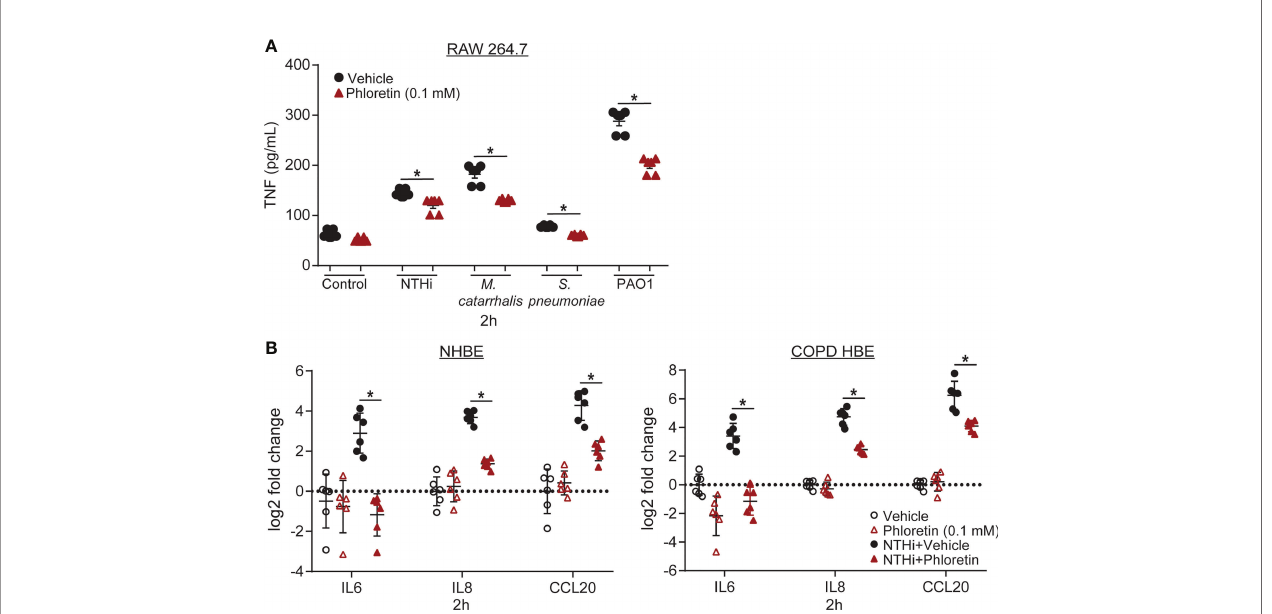
FIGURE 2 | Phloretin exhibits anti-in fl ammatory activity in COPD pathogen-induced RAW 264.7 cells and nontypeable Haemophilus in fl uenzae (NTHi)-induced human bronchial epithelial (HBE) cells. (A) COPD pathogens signi fi cantly increase TNF secretion from RAW 264.7 cells, which phloretin inhibits. RAW 264.7 cells were pretreated with 0.1 mM phloretin (1 h) and exposed to medium control, NTHi (2x10 5 CFU/mL, 50 µL), Moraxella catarrhalis (M. catarrhalis) (2x10 5 CFU/mL, 50 µL), Streptococcus pneumoniae (S. pneumoniae) (2x10 5 CFU/mL, 50 µL), or PAO1 (2x10 4 CFU/mL, 50 µL) for 2h. TNF was measured in the supernatant by ELISA. Results are the mean ± SEM of 2 independent trials with 3 biological replicates per condition tested within each trial ( n =6). P values were assessed by one-way ANOVA followed by Tukey ’ s multiple comparisons test to compare vehicle to vehicle+pathogen treated cells and to compare vehicle to phloretin treated cells